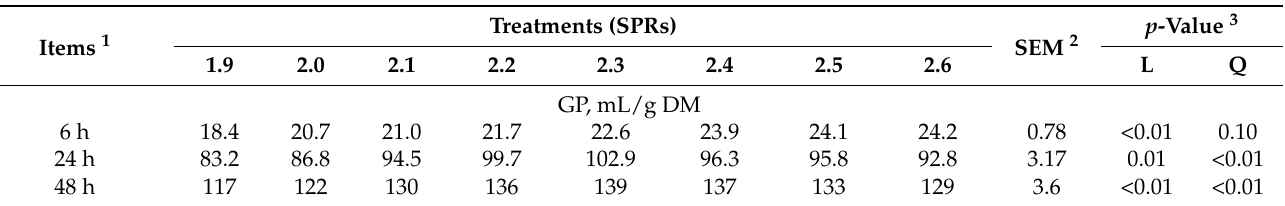
Table 3. Effects of dietary rumen-degradable starch to rumen-degradable protein ratio (SPR) on in vitro gas production